Question: Describe this figure in one sentence.
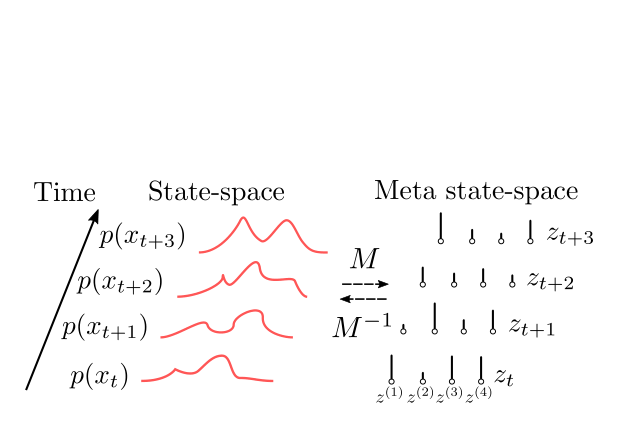
Answer: A graphical representation of the evolution of a PDF of the state according to (3) and the evolution of the meta-s- tate in terms of (9). This figure shows that meta-state vec- tors zt can represent the state distribution px t through the mapping M.